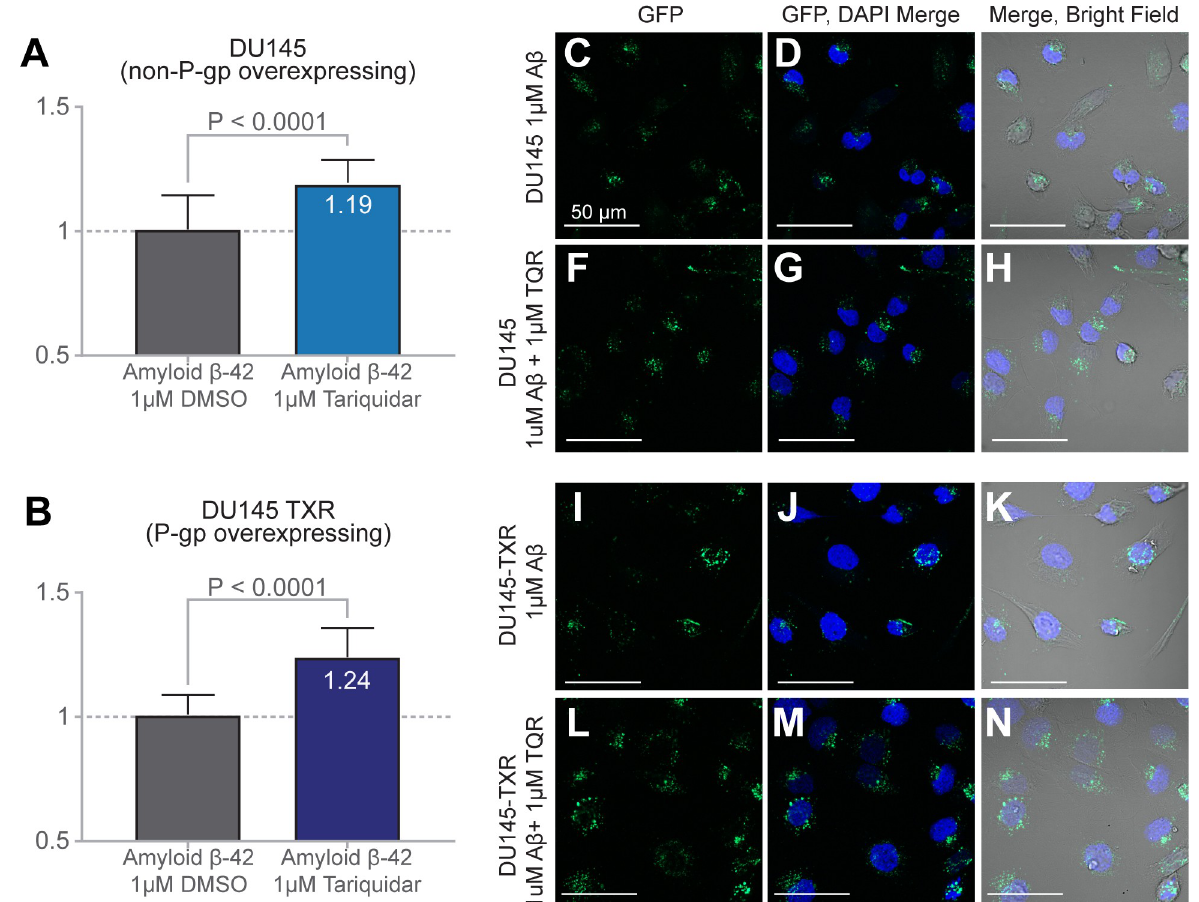
Fig 4. Intracellular accumulation of HiLyte-488-A β 42 in DU145 and DU145TXR cells after P-gp inhibition by tariquidar. The intracellular fluorescence of paired chemotherapeutic sensitive/resistant cancer cell lines (DU145 and DU145-TXR) was measured by confocal microscopy after a 16 hour incubation with fluorescently labeled A β 42. (A) When compared to treatment with 1 μ M DMSO control (no added TQR, grey bar), wild type P-gp expressing DU145 cells showed a significant 19% (P < 0.0001) increase in mean intracellular fluorescence when inhibited by 1 μ M of the P-gp inhibitor Tariquidar (TQR; blue bar, top panel). (B) Compared to treatment with 1 μ M DMSO vehicle (no added TQR, grey bar), treatment of P-gp overexpressing DU145-TXR cells showed a significant 24% (P < 0.0001) increase in mean intracellular fluorescence in the presence of 1 μ M Tariquidar (purple bar, bottom panel). Representative Images (C-E) show DU145 treated with 1 μ M A β 42 alone; (F-H) show DU145 treated with 1 μ M A β 42 and 1 μ M TQR; ( I-K) show DU145-TXR cells treated with 1 μ M A β 42 alone; (L-N) show DU145-TXR treated with 1 μ M A β 42 and 1 μ M